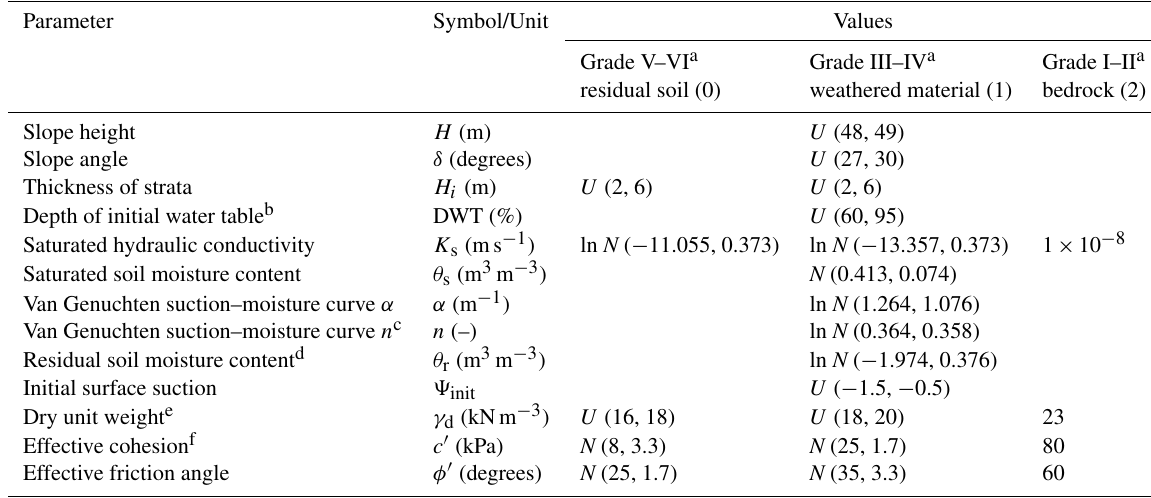
Figure 2. Conceptual model of the experimental slope. CHASM uses the Bishop method of slices to perform slope stability analysis, which involves a numerical search for the slip surface. Table 1. CHASM parameters and their